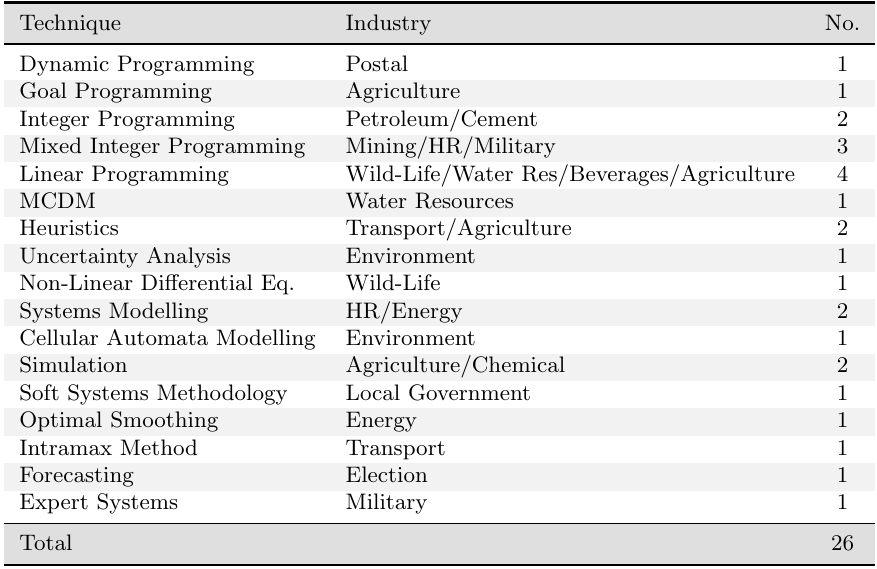
Table 5: A summary of the techniques used in applied work published in winning